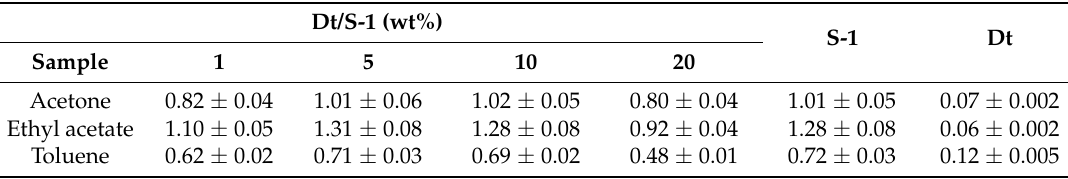
Table 2. Equilibrium adsorption capacities (mmol/g) of three probe volatile organic compounds (VOCs) on various